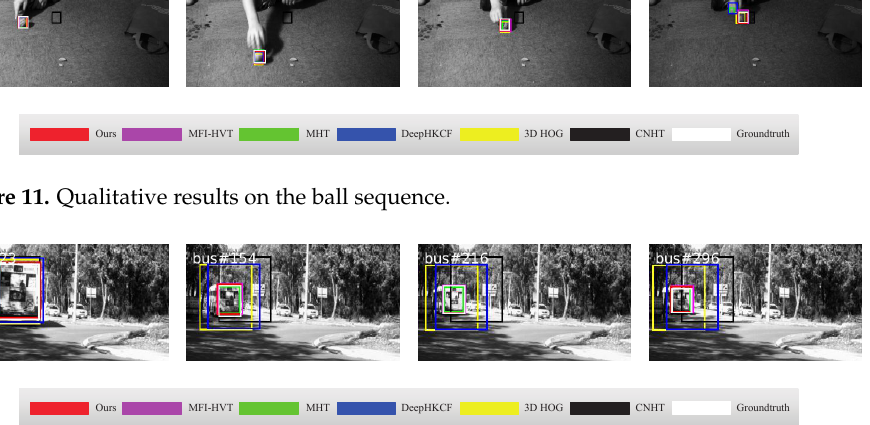
Figure 12. Qualitative results on the bus